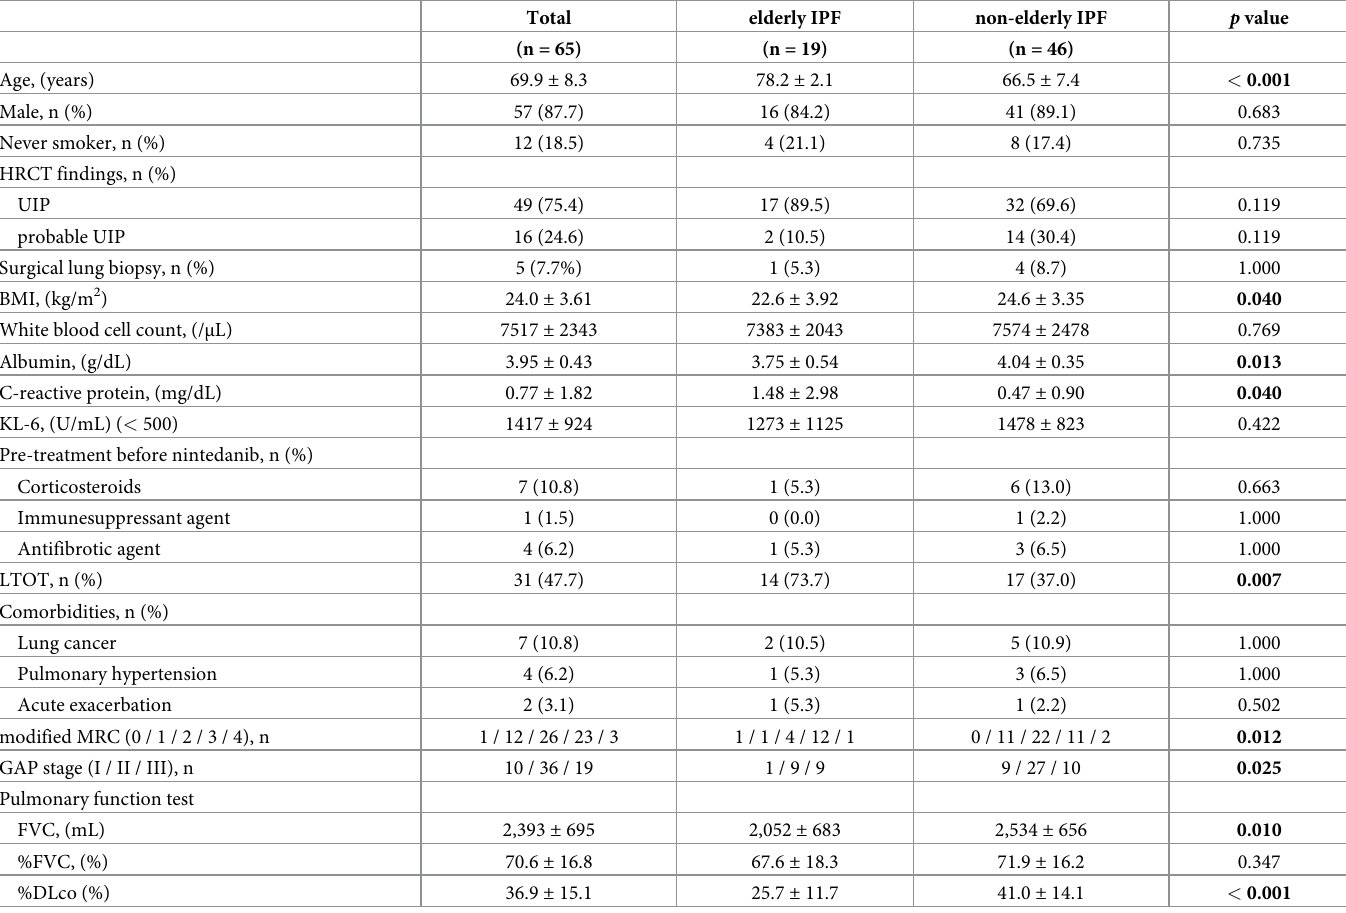
Table 1. Baseline characteristics of the 65 IPF patients.